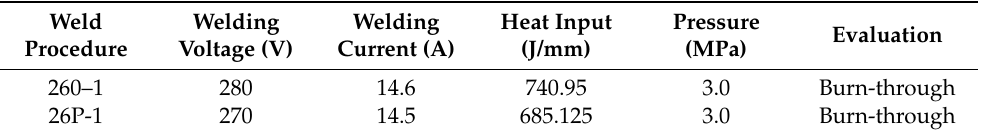
Table 4. Circumferential in-service welding observed with internal observation